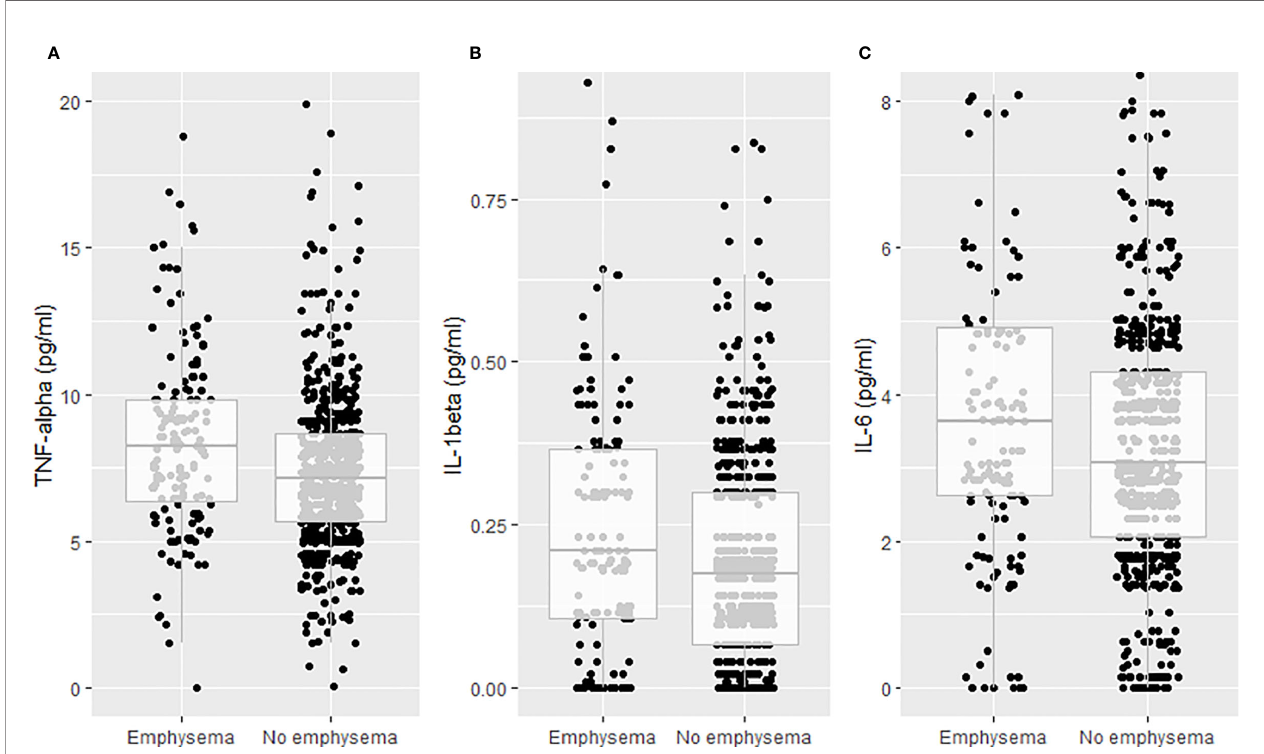
FIGURE 1 | Plasma concentrations of tumor necrosis factor-alpha (TNF a ), interleukin-1 beta (IL-1 b ) and interleukin-6 (IL-6) by radiographic emphysema. (A) TNF a . (B) IL-1 b . (C)